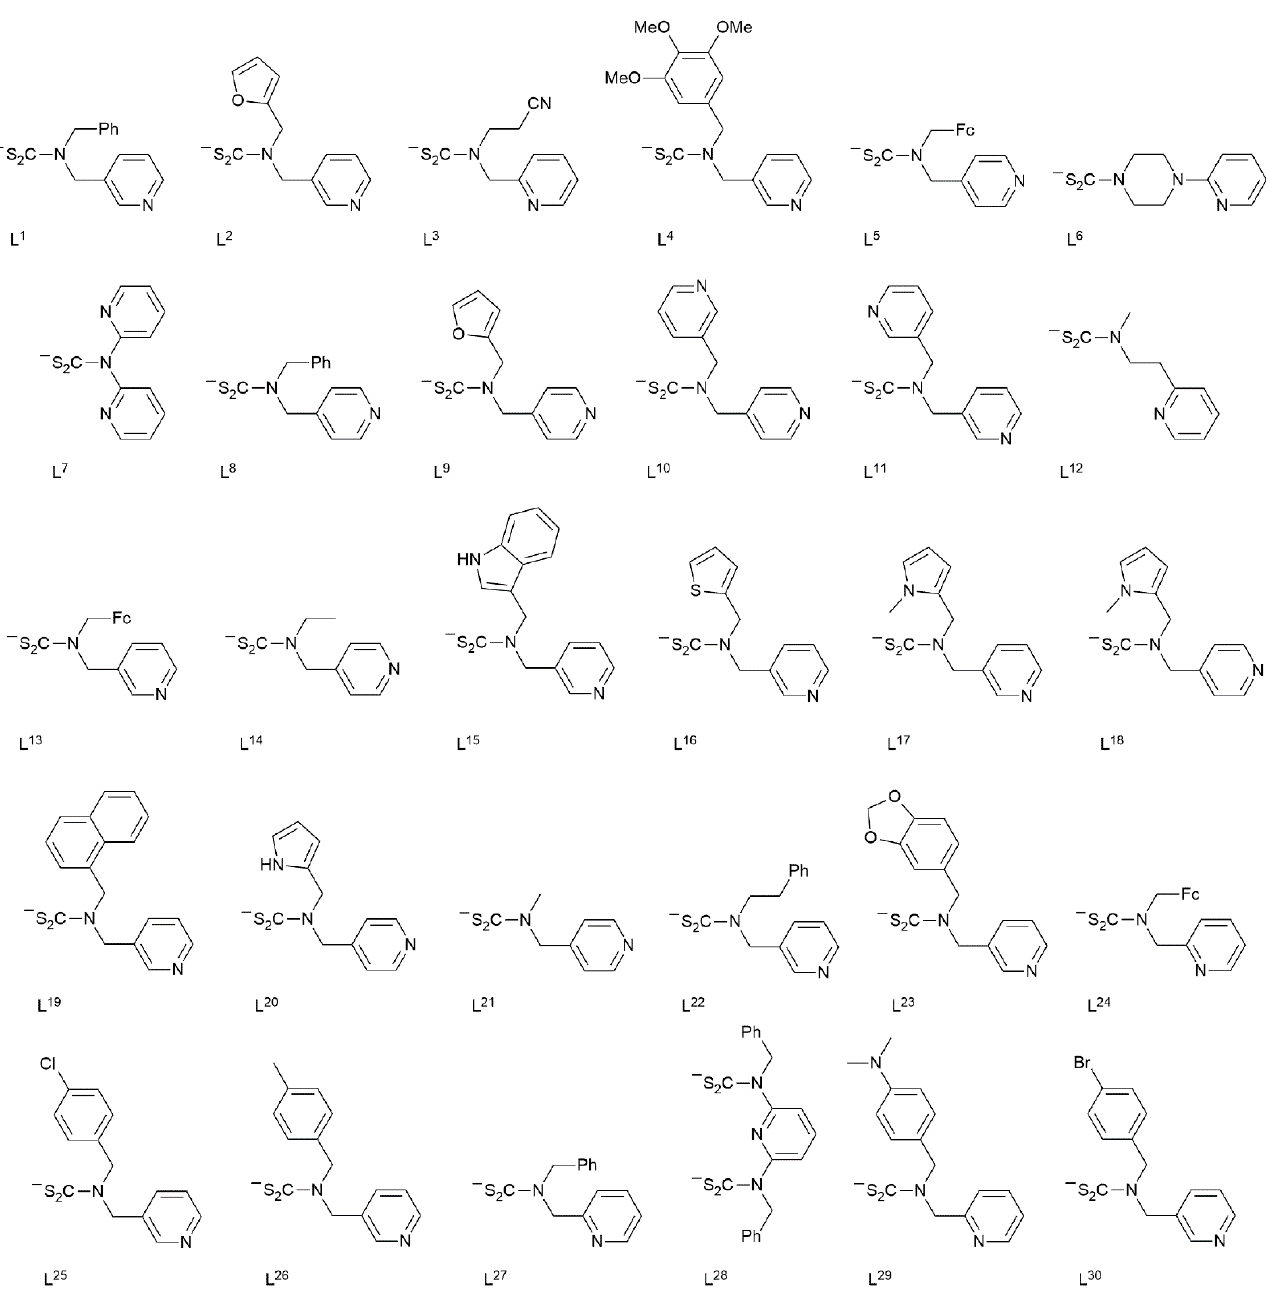
5 H 4 )Fe(C 5 H 5 ), ferrocenyl.